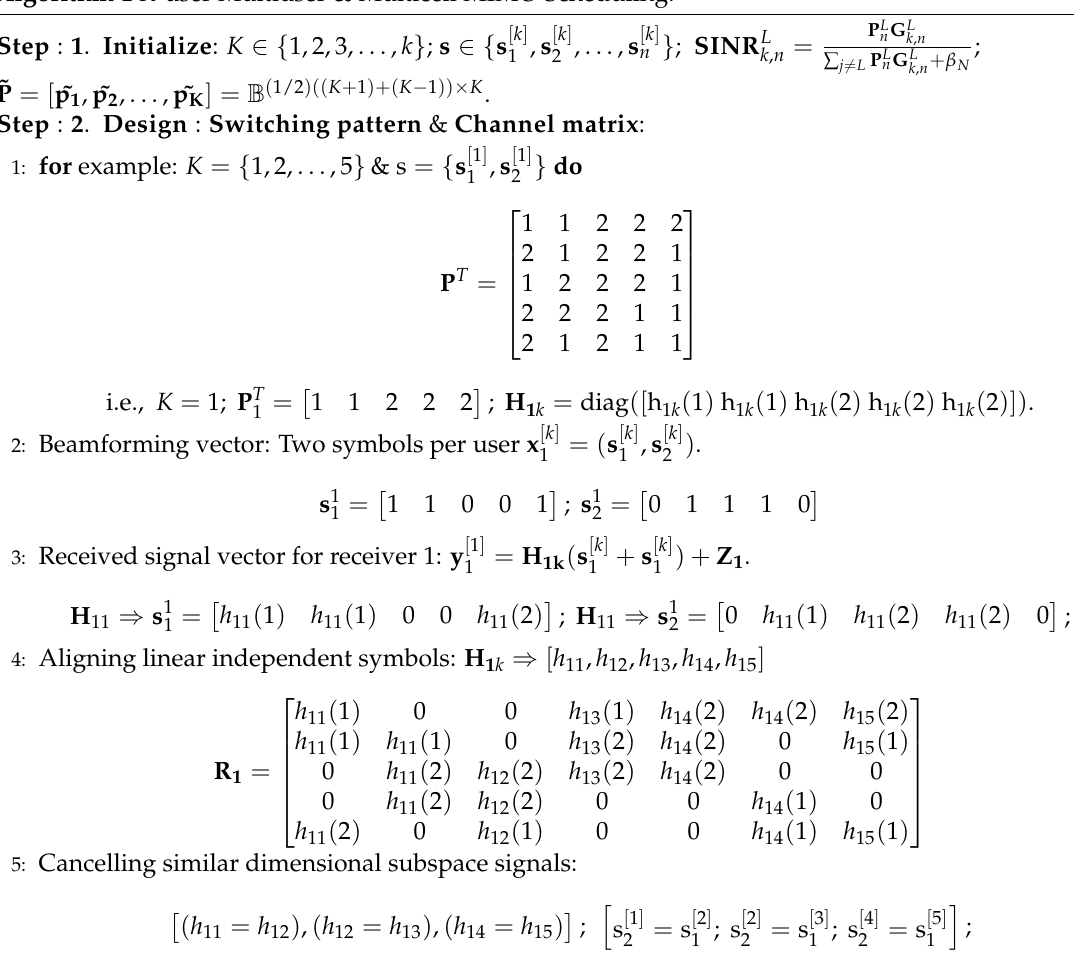
Algorithm 1 K -user Multiuser & Multicell MIMO